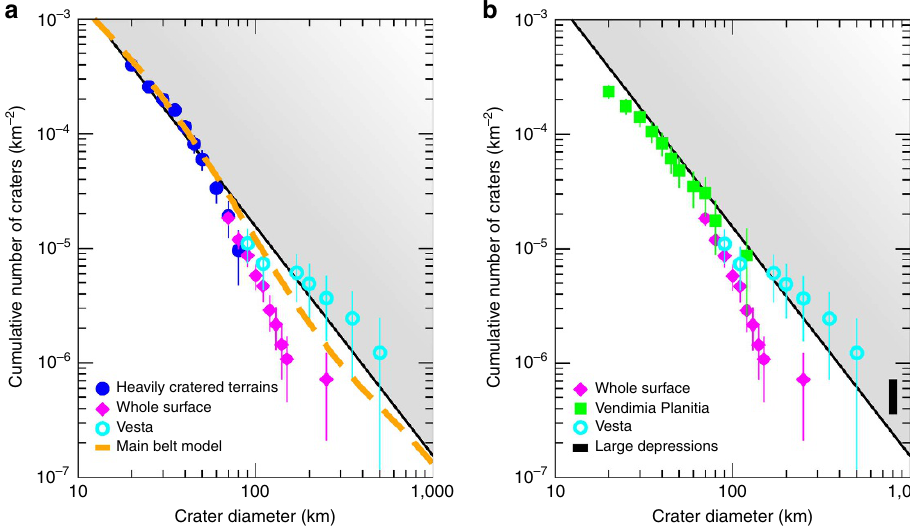
Figure 1 | Ceres global large crater size-frequency distribution. ( a ) Cumulative crater counts on the whole surface for diameter 4 70km (magenta). For a comparison, counts for the heavily cratered terrain (blue) are also reported: The drop-off at 70–80km is due to the limited area of the counting region (for latitudes northern than 50 (cid:2) N, B 15% of the surface). A model crater size-frequency distribution (dashed curve) is also reported (see Methods section). Note that the model curve has been vertically shifted to match the heavily cratered terrains at 20–60km, thus it underestimates the number of large craters produced over 4.55Gyr (see text). Black thin lines and shaded region mark empirical saturation, defined as 10% of the geometrical saturation 39 . ( b ) Crater cumulative counts for the northern part of Vendimia Planitia (green), as the southern part has been largely reset by the formation of Kerwan crater. The black vertical line indicates 1–2 basins of 800km in diameter (see text). Vesta’s large crater count 8 is also indicated (cyan). Error bars correspond to Poisson statistics of the cumulative